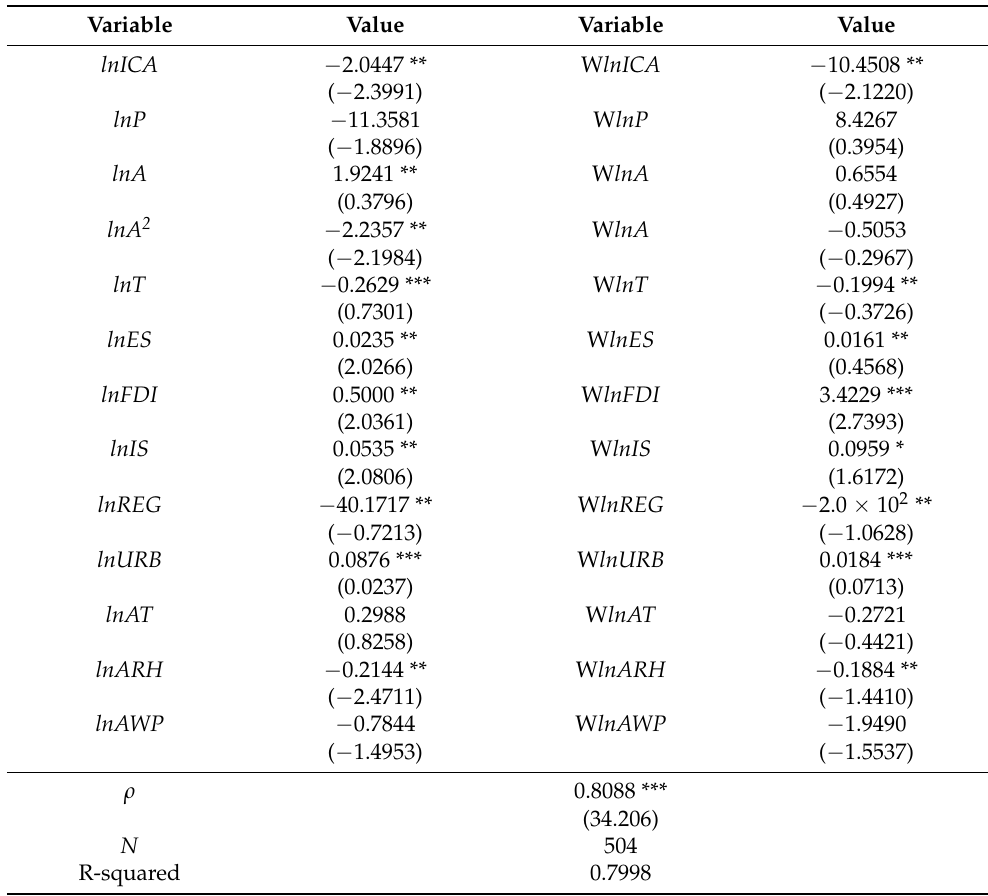
Table 4. Regression results for the